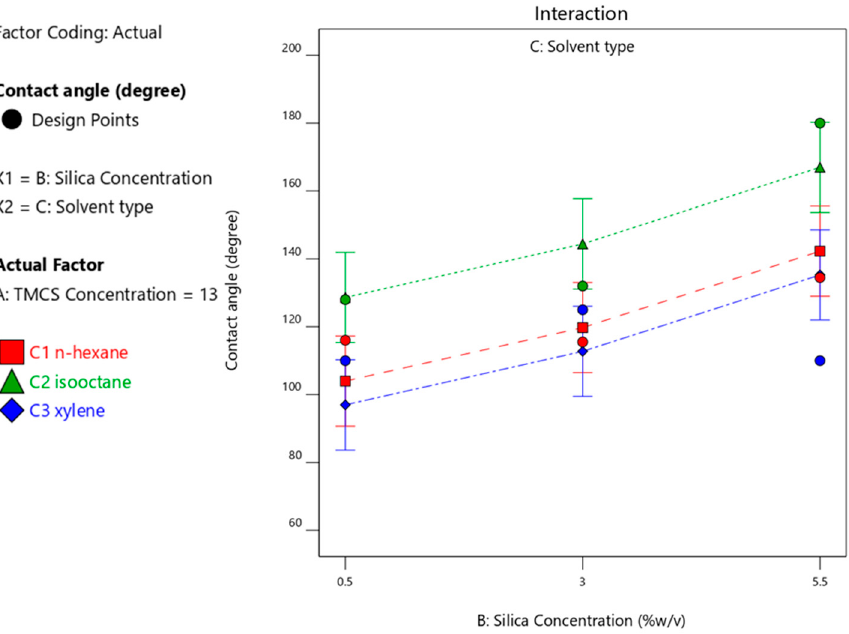
Figure 10. Contact angle response upon interaction between silica concentration and solvent type with 13%- v / v TMCS.